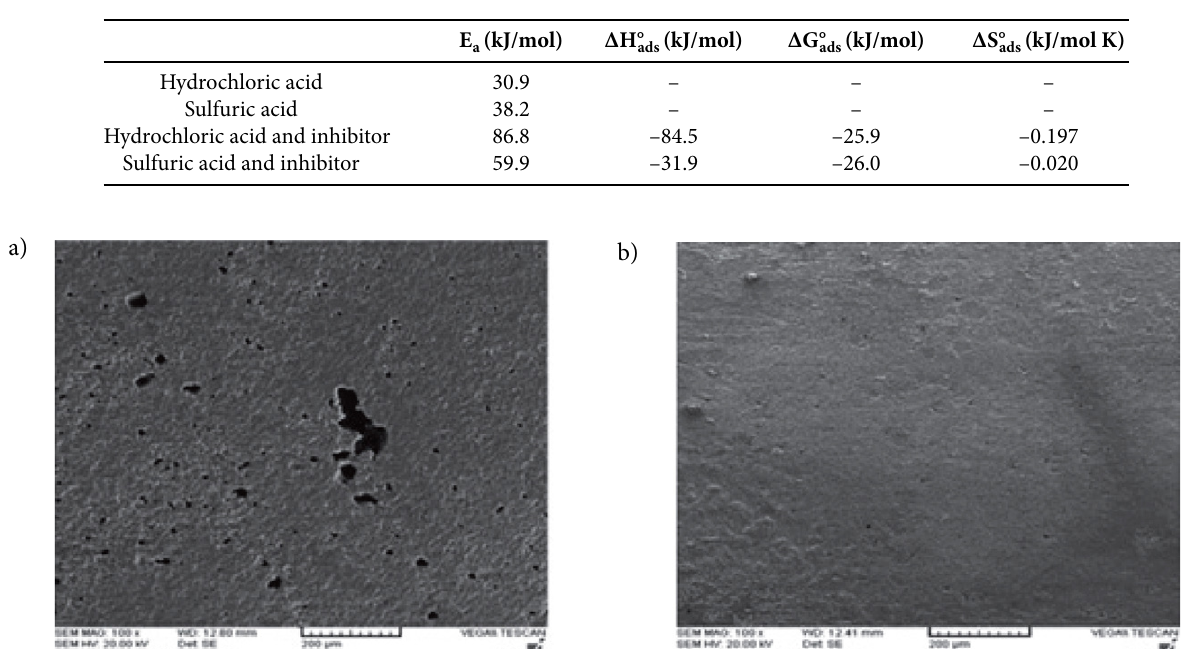
Figure 9. SEM images of mild steel in 1.0 M hydrochloric acid solution, a) blank, b) with inhibitor.